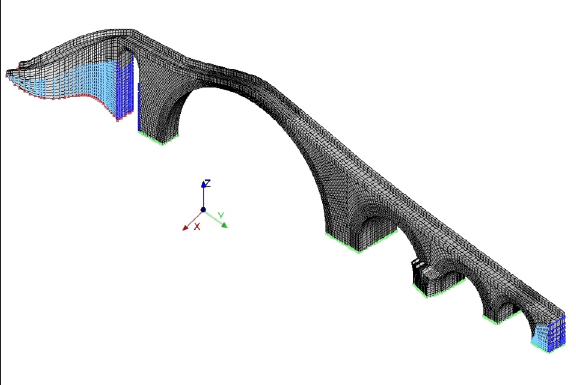
Figure 13. Finite-element model of the Maddalena Bridge. Blue dots: fixed displacements in the xy plane; cyan dots: fixed displa- cements along x ; red dots: fixed displacements in the three di- rections; green dots: linear elastic springs along z and fixed displa- cements in the xy